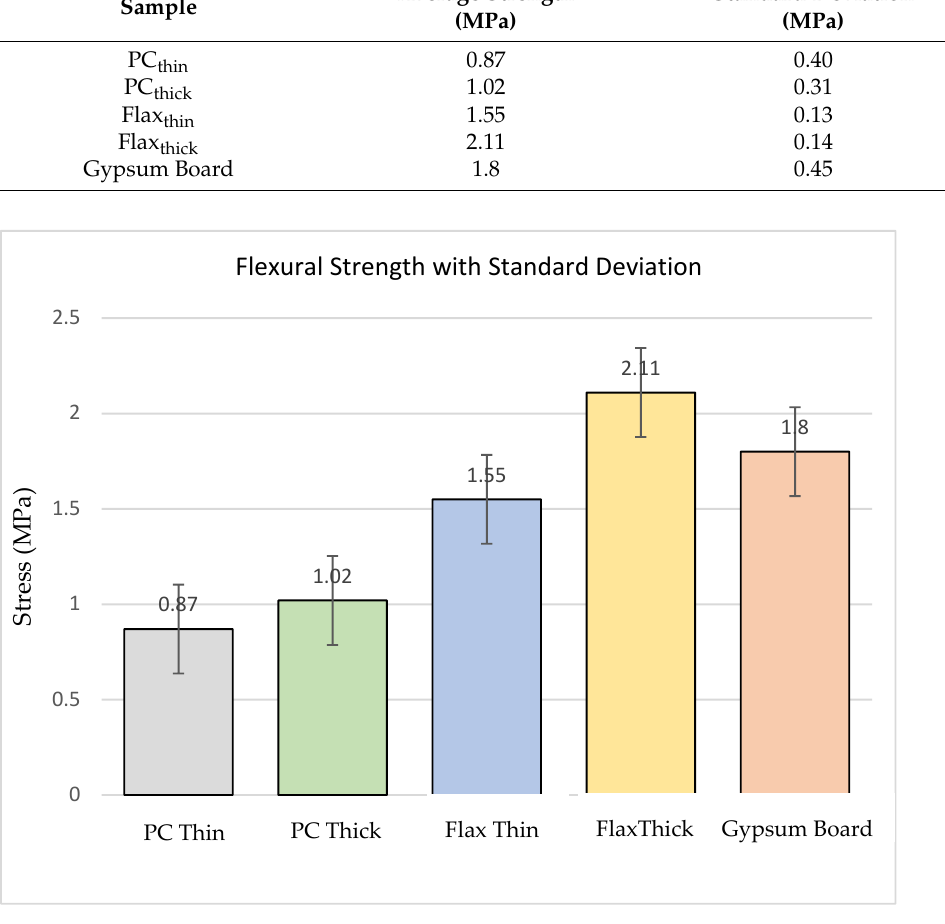
Figure 7. The average ultimate strength of honeycomb sandwich panels with standard deviation.